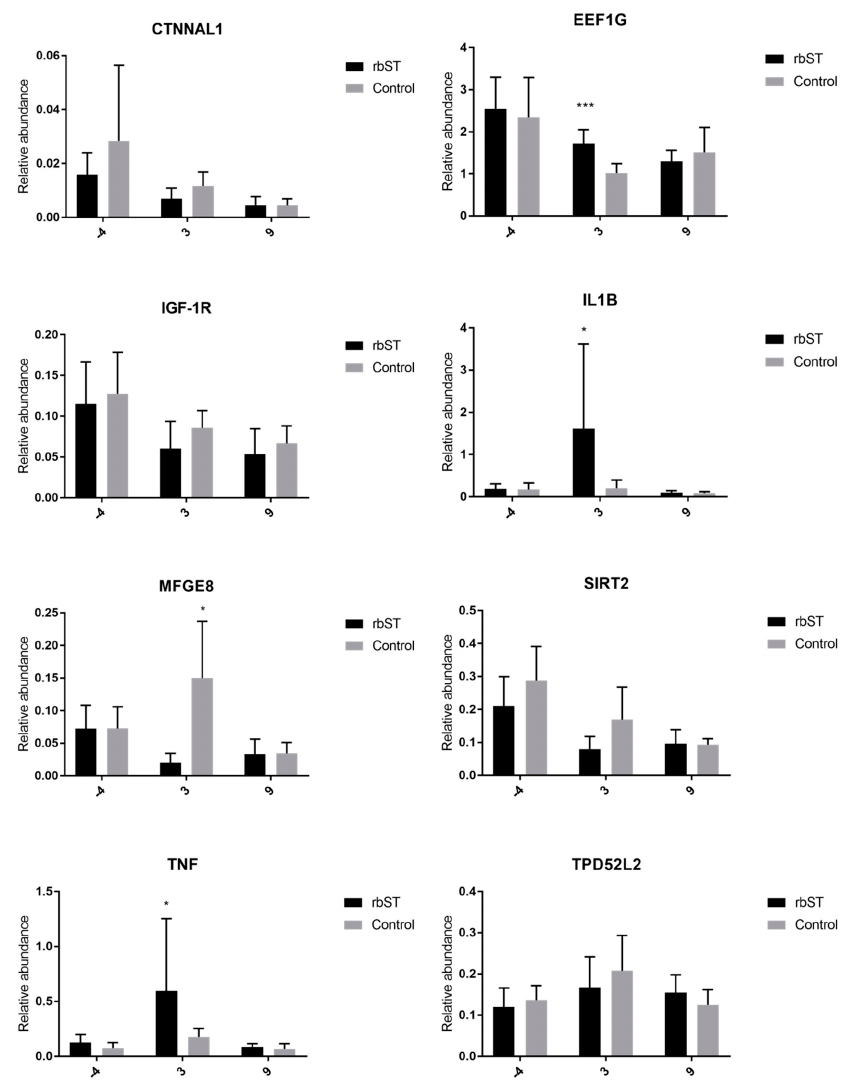
Figure 2. Relative abundance of target genes expressed in blood samples before the administration of recombinant bovine somatotropin (rbST), and on the third and ninth days after rbST administration. The bars represent the mean value of each group (rbST and control). The value used for each animal is the mean of three replicates; * p < 0.05, *** p < 0.001.